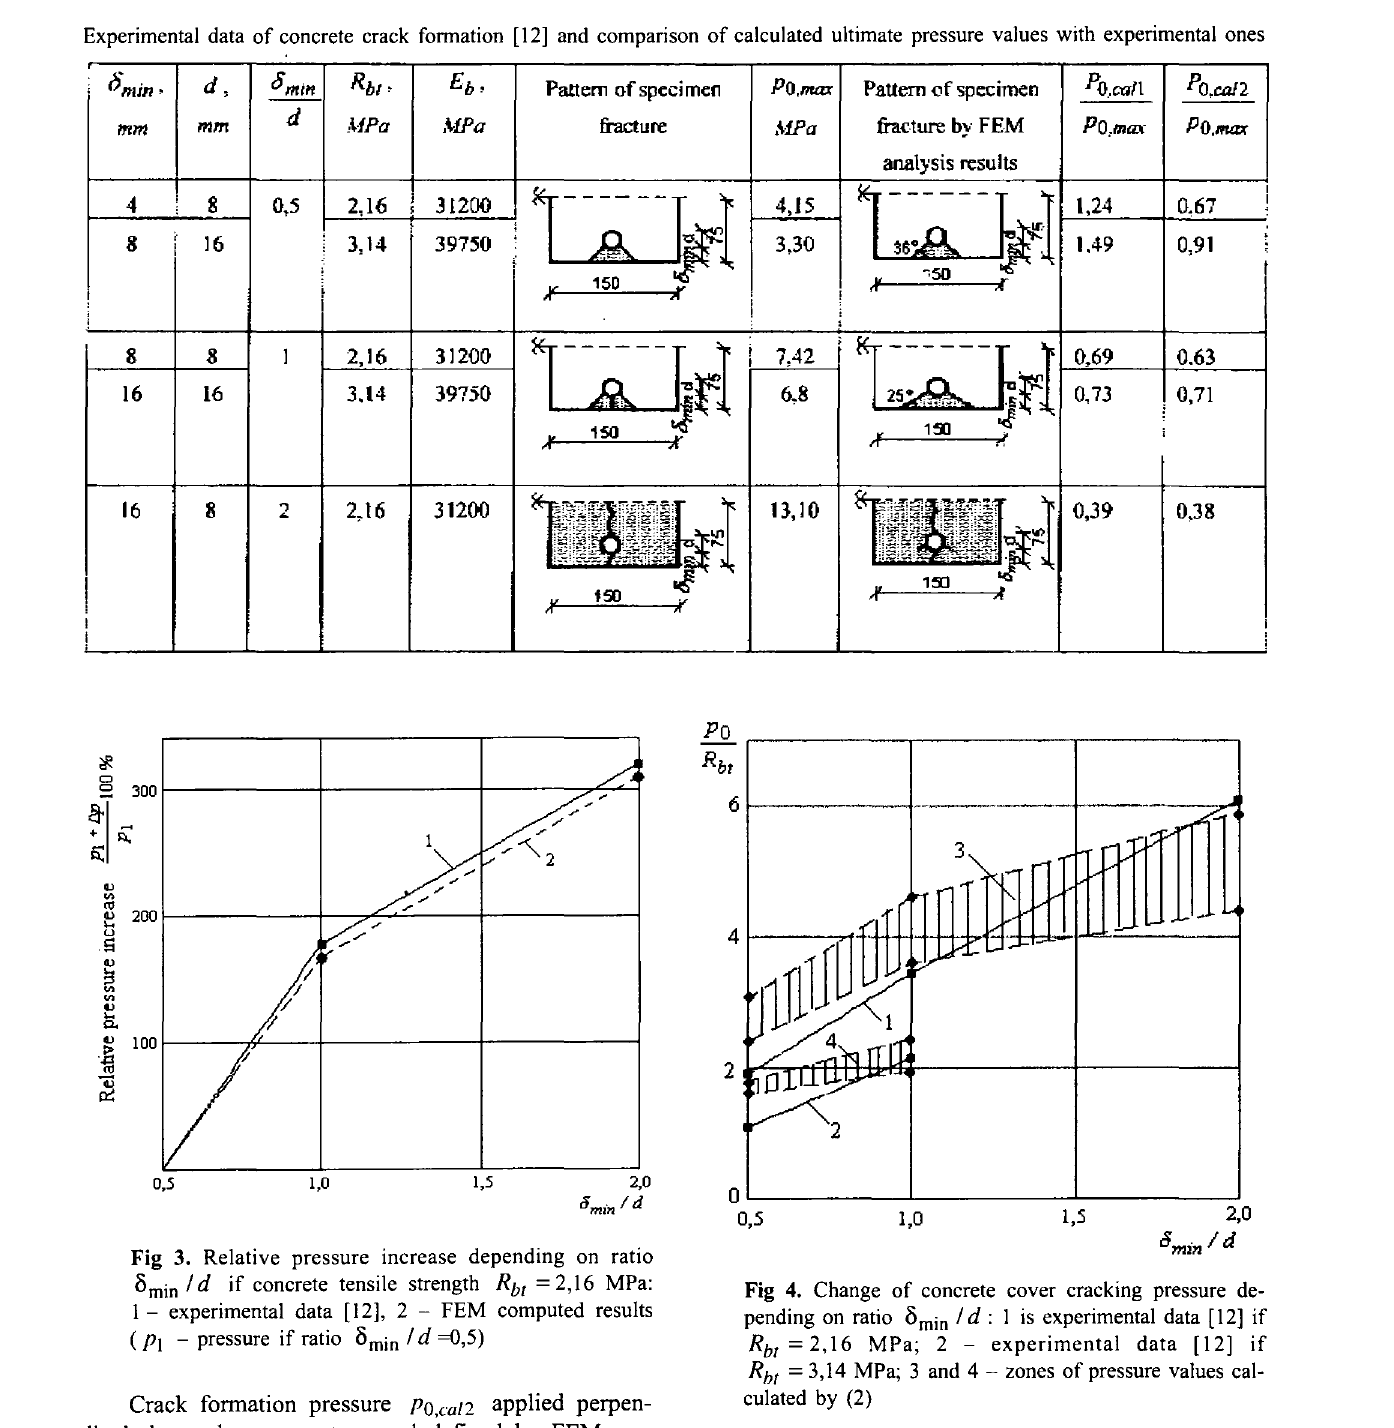
Fig 3. Relative pressure increase depending on ratio Omin I d if concrete tensile strength Rbr = 2,16 MPa: I- experimental data [12], 2 - FEM computed results (PI - pressure if ratio Omin I d =0,5) Crack formation pressure Po,ca/2 applied perpen dicularly to the cut contour and defined by FEM was compared with the experimental pressure Po,max (Table). Values of limit pressure Po,ca/2 in comparison with ex perimental Po.max values decrease when increasing Omin I d ratio. It is because with the increase of this ra tio the difference between limit pressure at the cracking start (it corresponds to PO.call and Po,ca/2 values) and experimental Po,max pressure at the stage of complete fracture of cubes actually increases. Relative increases in limit pressures (Fig 3) calculated by FEM and deter mined experimentally are very close.